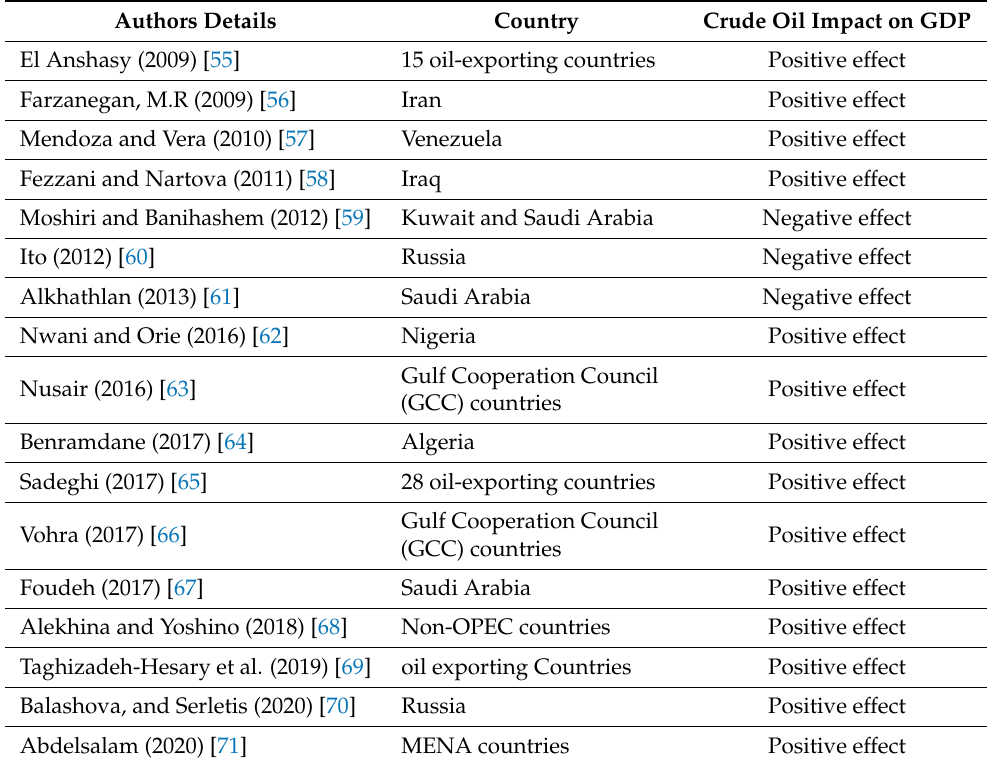
Table 1. Executive Summary on the Literature